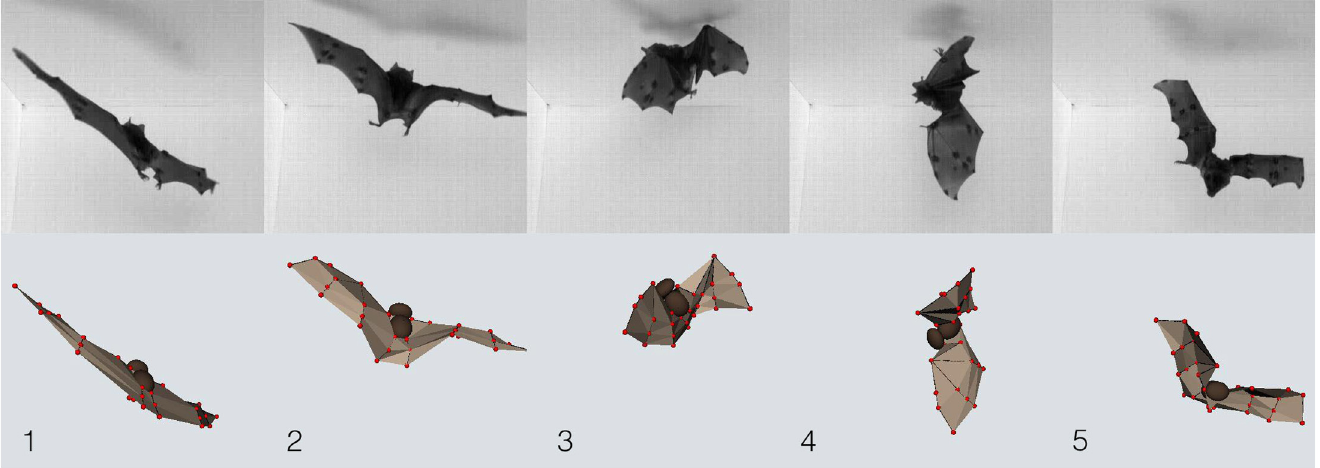
Fig 2. Bats rapidly reorient their bodies during landing. (Above) Selected images from high-speed recordings of C . perspicillata executing a landing maneuver and, upon failing to find a landing site, executing a righting maneuver. (Below) Corresponding 3-D reconstruction of the 52-degree-of-freedom flight kinematics. The images from left to right correspond to t = 0.185 s, 0.26 s, 0.335 s, 0.41 s, and 0.485 s (also, see Fig 3). To give a sense of scale, C . perspicillata have a characteristic tip-to-tip wingspan of approximately 30 cm. Tracked video data available in file tracked_data.zip from the Dryad Digital Repository, http://dx.doi.org/10.5061/dryad.21qs5